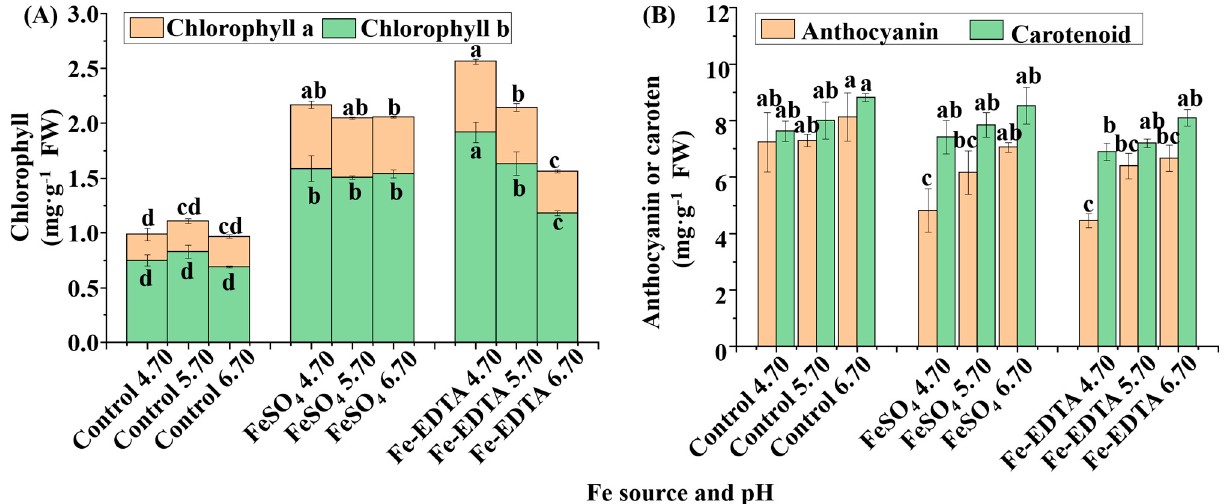
Figure 3. The contents of chlorophylls ( A ), carotenoid, and anthocyanin ( B ) in H. macrophylla after 60 days of cultivation; FW, fresh weight. Vertical bars indicate the standard error ( n = 3). Lowercase letters indicate significant differences calculated by Duncan’s multiple range test at p ≤ 0.05. Table 5. Correlation analysis between the leaf color and leaf pigment contents in this study.